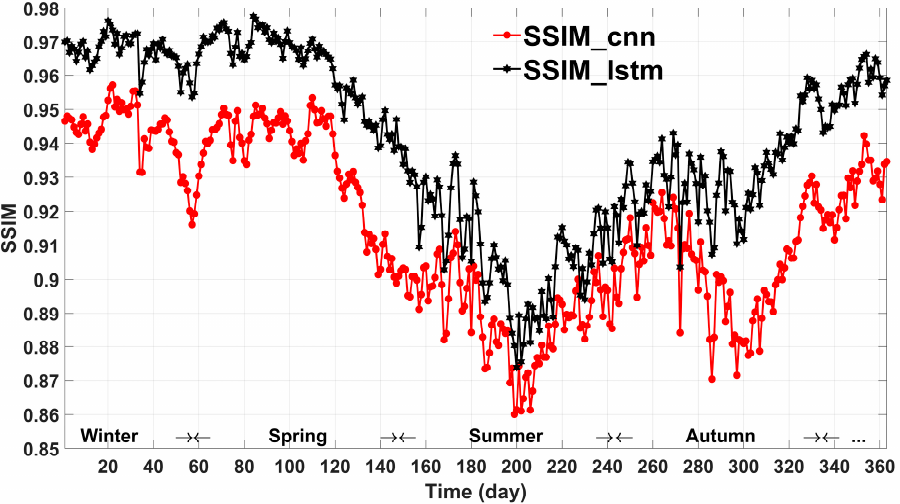
Figure 6. SSIM comparison of CNNs and ConvLSTM. The black line in the figure represents the SSIM of ConvLSTM, and the red line represents the SSIM of CNNs.